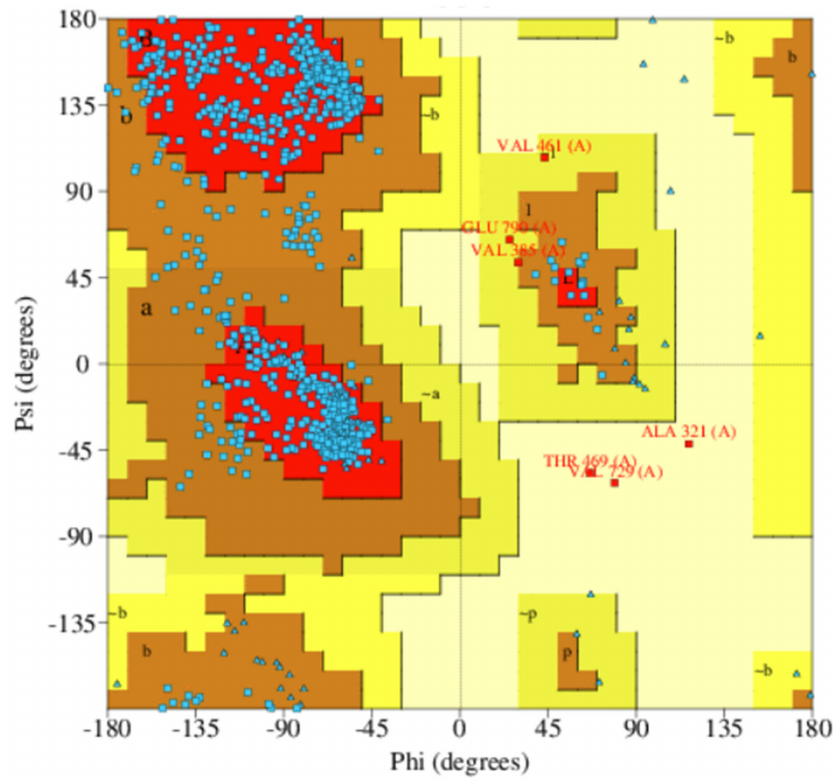
Figure 3. Ramachandran plot of the selected Ld CRK12 structure (ROB1) obtained via PROCHECK. The percentages of residues in the most favored regions, additionally allowed regions, generously allowed regions and disallowed regions are 82.0%, 17.1%, 0.4%, and 0.4%, respectively.